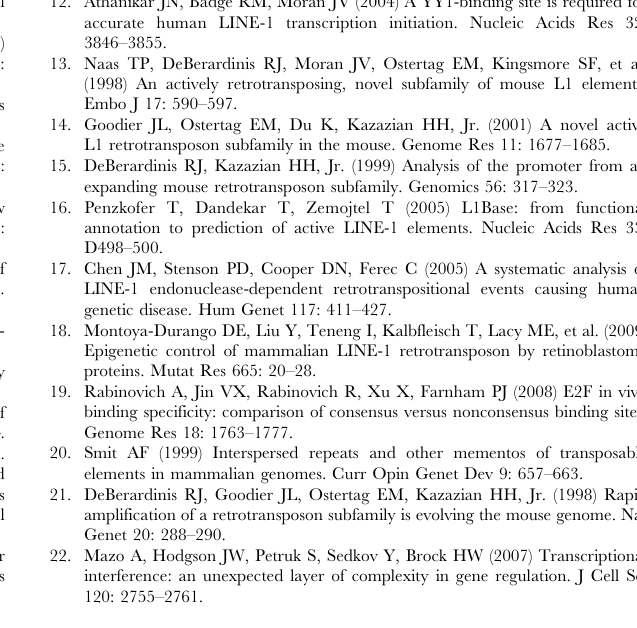
Table S3 The distribution of L1 elements in intergenic regions in mouse chromosomes. PDF) Table S4 The distribution of L1 elements with neighboring genes in mouse chromosomes. PDF) Table S5 The list of L1s’ neighbouring genes and their locations. Table S6 List of tissue-specific genes in the vicinity of L1 elements within 20-kb distance. Table S7 The mutation rates at the YY1 transcription binding sites in Tf subfamily.